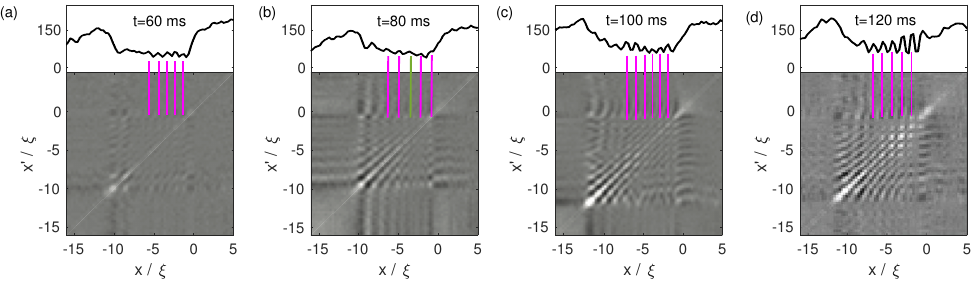
Figure 1: Experimental density and density-density correlations taken from [ 3 ] . Top: the 〉 ; bottom: density-density correlation. Panels ensemble average of experimental density, 〈 n exp (a)-(d) are measured at times t = 60, 80, 100, 120 ms, respectively. The periodic features of the standing waves are very close to those of the checkerboard patterns in the correlation, as indicated by the magenta vertical lines; the green line in panel (b) indicates the only mismatch, where the standing wave peak falls in a trough of the correlation pattern. Note that all the plots are based on the length unit ξ of the system, ξ = 2 µ m, and the origin x = x (cid:48) = 0 is defined at the step edge (i.e. the